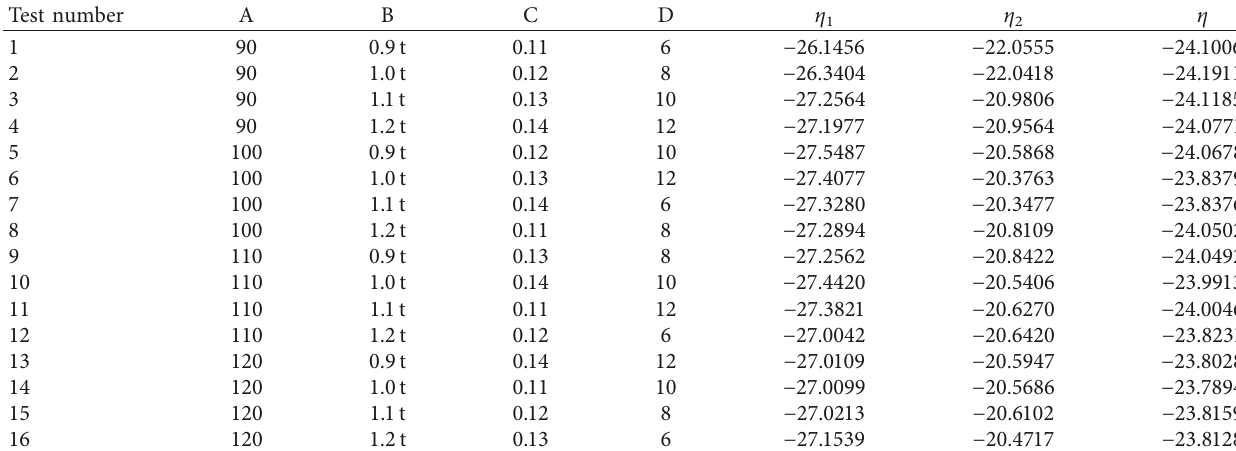
Table 6: The result of SNR calculation.